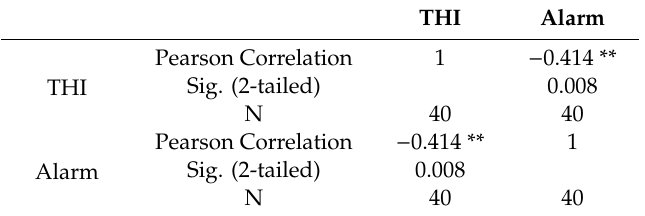
Table 5. Correlations between the alarm and temperature-humidity index (THI).